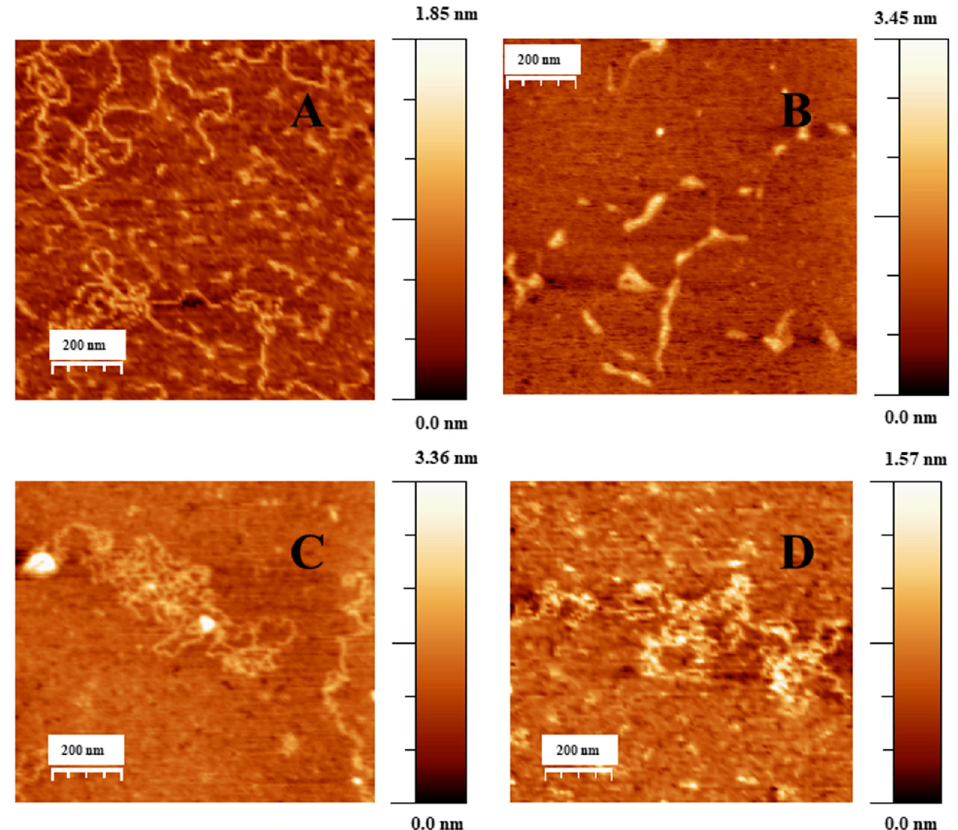
Figure 3. AFM topography image of DNA and DNA/Doxo complexes adsorbed on the APTES modified mica surface in cacodylate buffer (I = 1.63 mM, pH = 7.4), C DNA = 0.3 µ M. ( A ) DNA in extended-coil conformation in the absence of Doxo. ( B – D ) Structure of DNA–Doxo complexes, C Doxo = 7.5 nM.